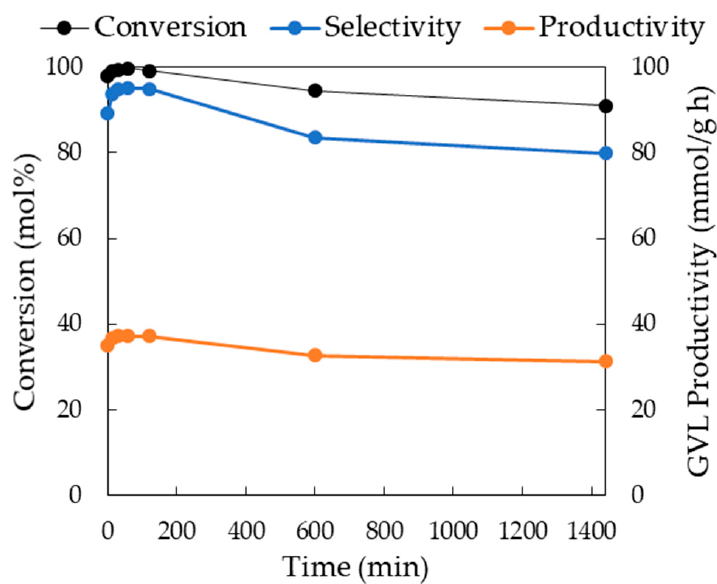
Figure 6. Long-term evaluation of ZrO 2 /Si-SBA-15 catalytic performance in the continuous transformation of methyl levulinate into Υ -valerolactone. Reaction conditions: 0.3 M ML solution, 0.1 g of catalyst, 0.2 mL/min flow rate, 30 bar, 200 ◦ C. Time on stream up to 24